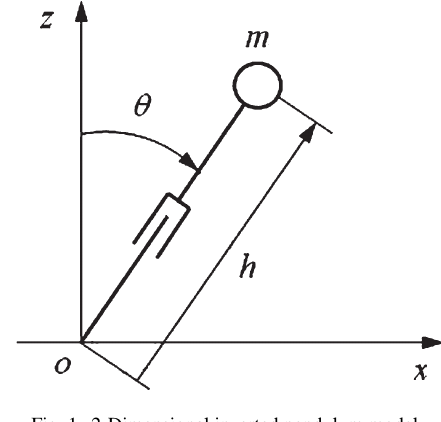
Fig. 1. 2-Dimensional inverted pendulum